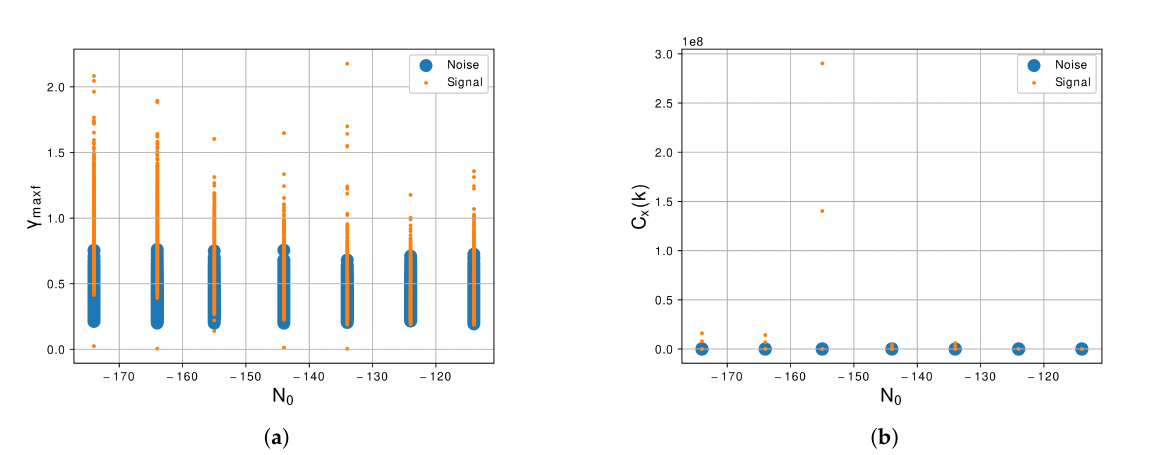
Figure 7. Graphic of the features ( a ) γ maxf , Equation (9), and ( b ) C x ( k ) , Equation (10), with the variation of N 0 of − 114 dBm/Hz to − 174